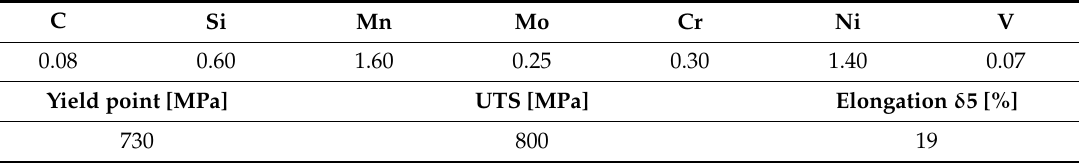
Figure 1. Welding process of the Strenx 700 MC steel: Sequence of the beads ( a ), macro-etched cross-section of the final weld ( b ). Table 3. ESAB OK Aristorod 69 chemical composition (wt.%) and mechanical properties.